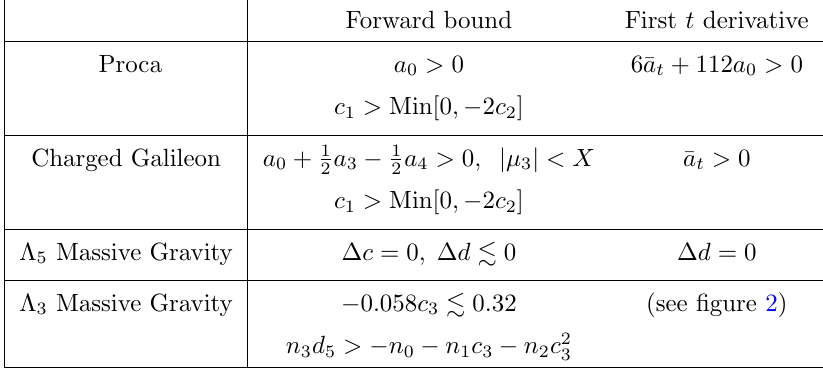
Table 1 . Summary of the leading order positivity bounds for massive spin-1 and spin-2 EFTs. See equations (3.5), (4.5), (6.17), (6.19), (7.3) for de(cid:12)nitions of these EFT coe(cid:14)cients. The (cid:3) 3